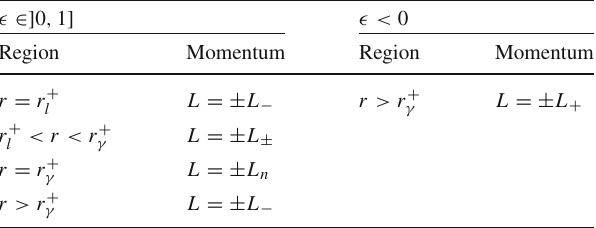
Table 1 Characteristics of the circular orbits for charged test particles with charge-to-mass ratio (cid:2) ≤ 1 in a RN black hole (cid:2) ∈] 0 , 1 ]